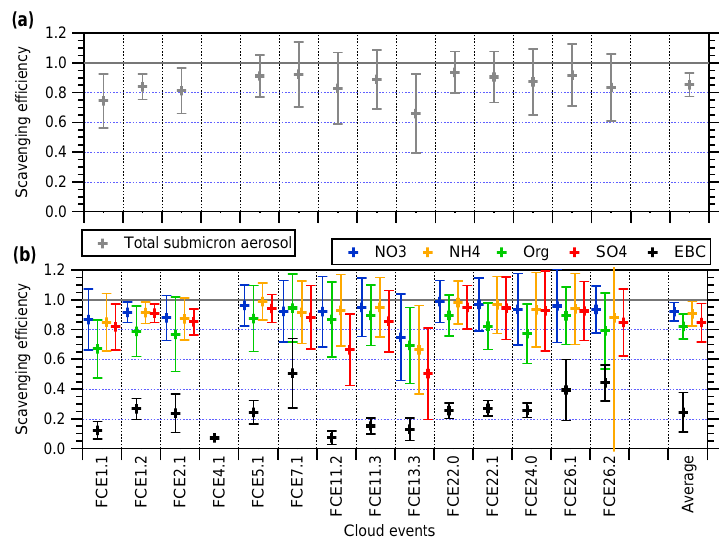
Figure 7. Partitioning between cloud phase and interstitial phase: scavenging efficiency SE = M cloud residuals /(M cloud esiduals + M intersitital ) for the total aerosol mass (a) and the individual compounds (b) . During FCE4.1, cloud residual data were not measured with the AMS. Error bars represent standard deviations of the time-resolved scavenging efficiencies during the individual FCE combined with the uncertainty of the CVI correction